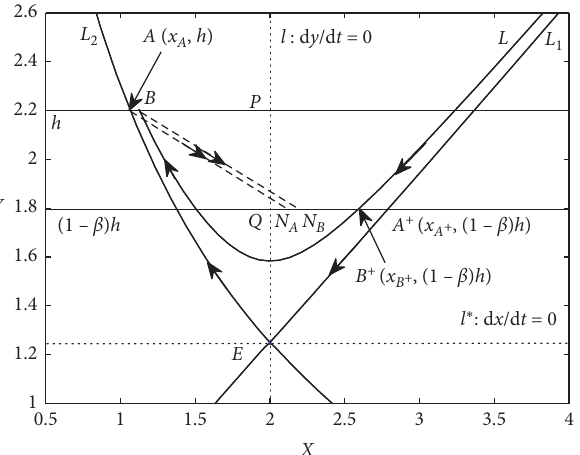
0.5 Figure 4: Trajectory L passing B + and impulse mapping of B with parameter values: a � 5 , c � 4 , d � 6 , e � 3 ,h � 2 . 2, and β � 0 . 2.